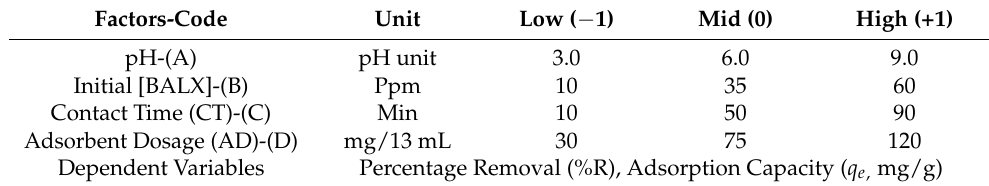
Table 1. Variables and their lower, mid, and upper levels. Two dependent variables were